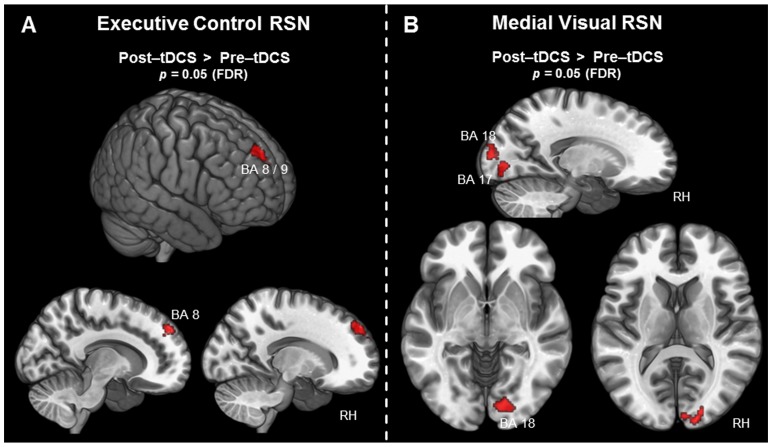
Voxel-wise difference maps for the executive control and the medial visual RSN.Activity is displayed at a cluster-level threshold of p<0.05 (FDR corrected) and projected on the MNI template brain (ICBM 152). A) Areas associated with the executive control RSN exhibiting increased activity following tDCS. B) All areas associated with the medial visual RSN exhibiting increased activity following tDCS. (BA =  Brodmann area; FDR =  false discovery rate; RH =  right hemisphere; RSN =  resting-state network).